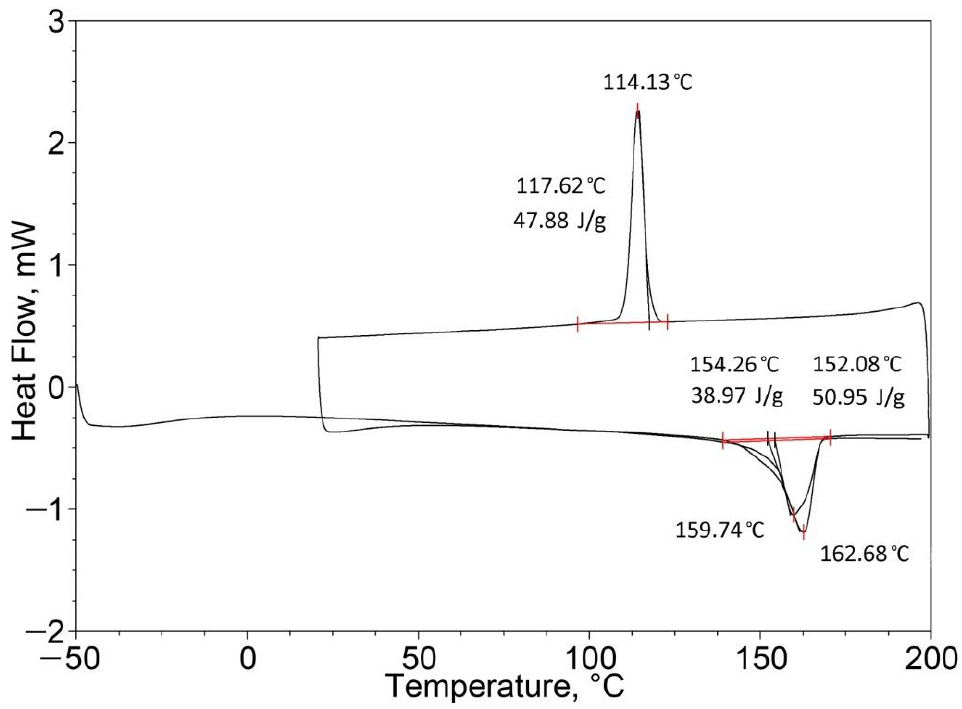
Figure 14. Melting-crystallization-melting diagram (DSC scan curves) of the 50% PP–50% EPTSR polymer blend produced by SEDS method.